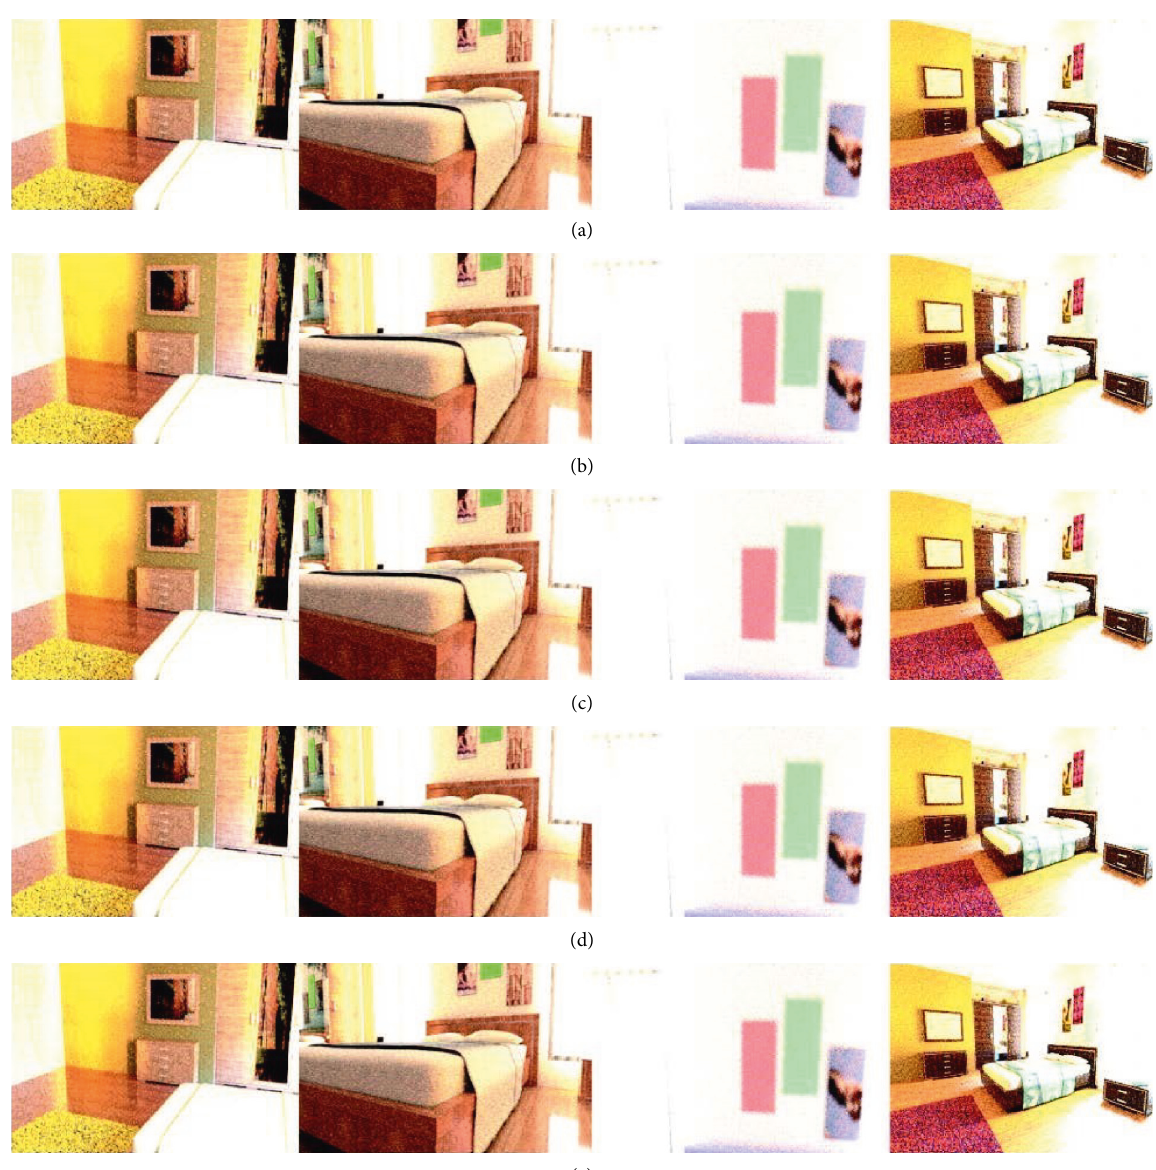
Figure 6: Noise reduction effect of Monte Carlo algorithm based on deep neural network. (a) Input SSIM � 0.99, RelMSE � 126.433. (b) NFORSSIM � 0.9985, RelMSE � 9.271. (c) KPCN SSIM � 0.9987, RelMSE � 5.578. (d) Ours SSIM � 0.9993, RelMSE � 3.228, (e) Reference dynamic change